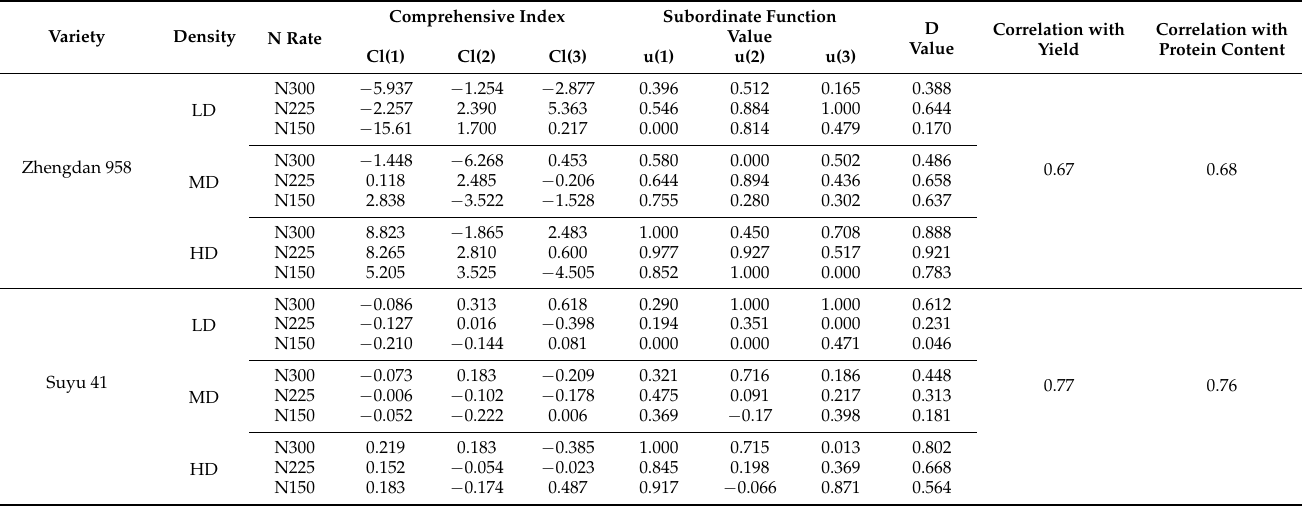
Table 5. Comprehensive index value (Cl), subordinate function value u(X), comprehensive evaluation value (D) and correlation analysis in 2020.